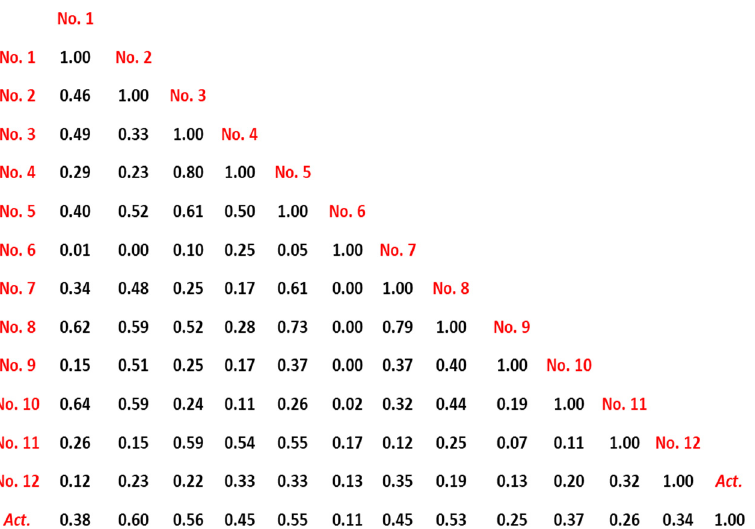
Figure 1. The correlations matrix for the selected 12 descriptors along with catalytic activity.